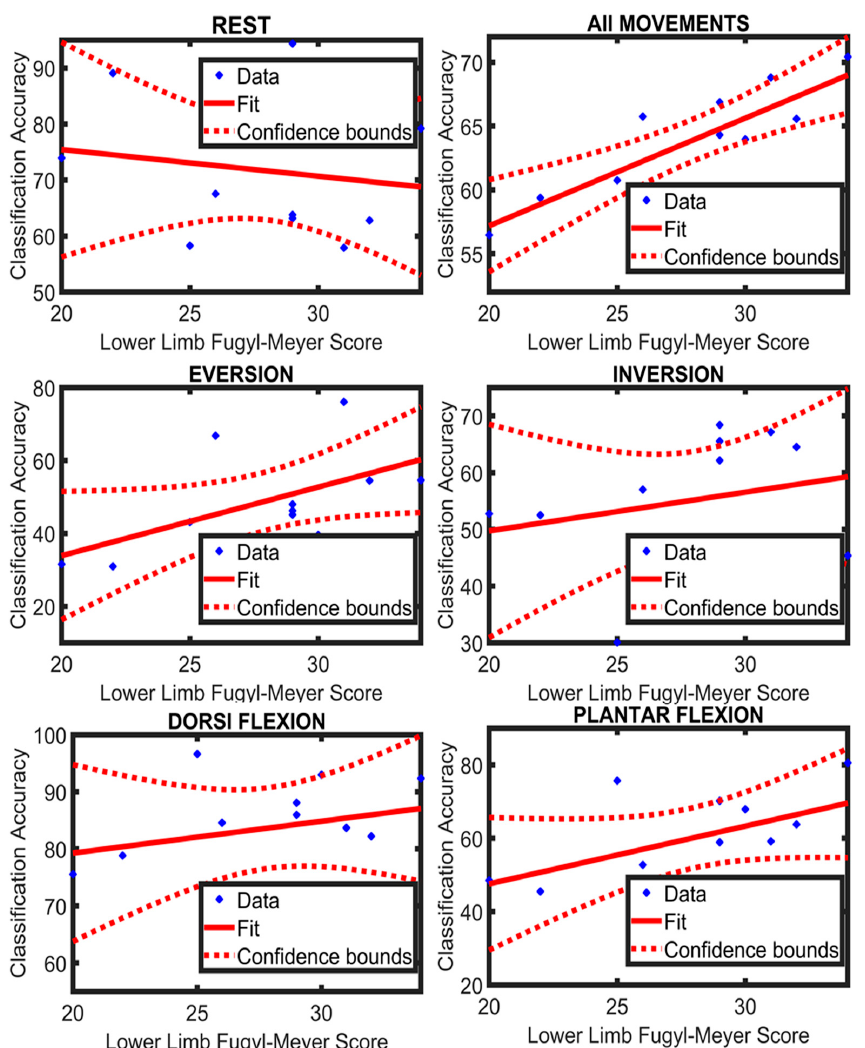
Figure 7. A regression line fitted to the participants’ data of Limb Fugl ‐ Meyer score and their classification accuracies (LDA) of individual movement and all movements combined.